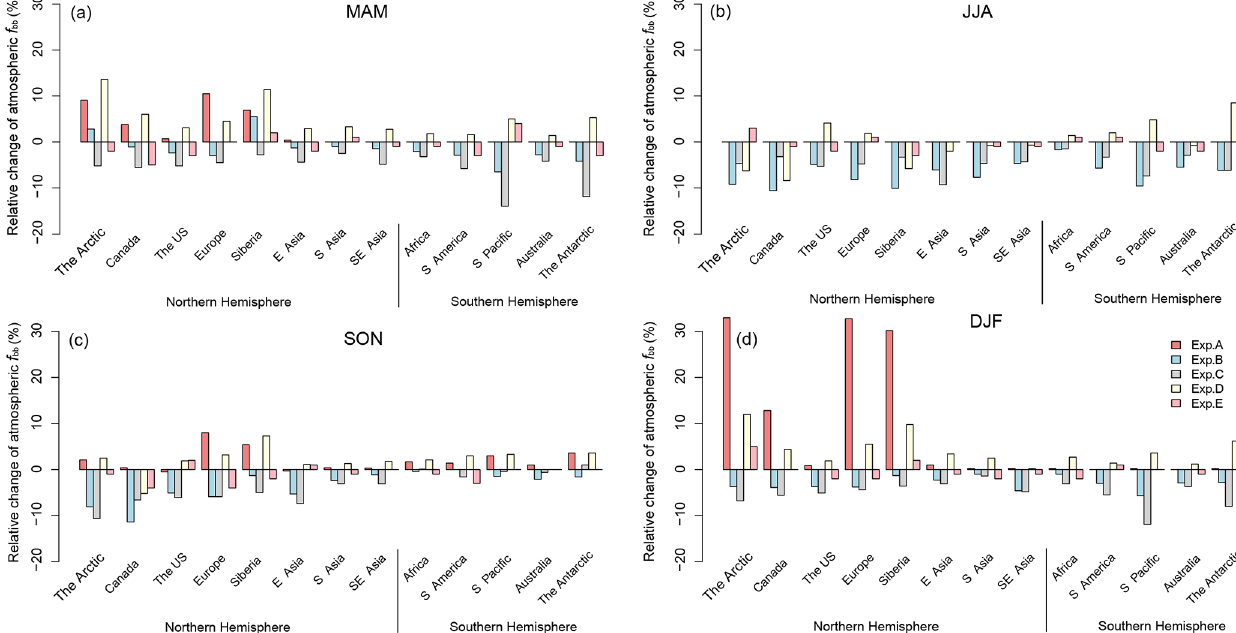
Figure 4. GEOS-Chem-simulated fractional change ( r ) to atmospheric f bb relative to the standard simulation, as a result of doubled biofuel emissions north of 45 ◦ N (Exp. A), 70% of hydrophilic BC in freshly emitted biomass burning BC-containing particles (Exp. B), 4h e - folding aging time of BC in biomass burning plumes and linear aging rate of 1% in fossil fuel plumes (Exp. C), TOMAS microphysical aging and scavenging (Exp. D), and finer horizontal model resolution (2 ◦ lat × 2.5 ◦ lon; Exp. E), r = ( [ f bb ] Exp . −[ f bb ] Std . )/ [ f bb ] Std . , which varies with regions (see region definition in Fig. 3a) and seasons ( a : March–May – MAM; b : June–August – JJA; c : September–November – SON; d : December–February – DJF), averaged for 2007–2013. See details of the standard simulation and the uncertainty experiments in the